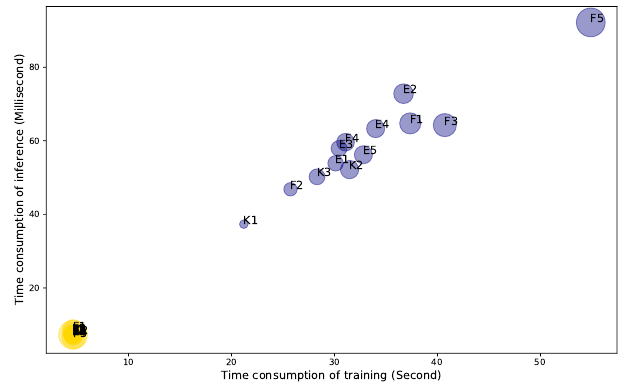
Figure 13. Training and inference time consumption for each length of each drawing pattern. Bubble size corresponds to the length of sequence. E, F, and K denote English, freestyle, and Korean patterns,